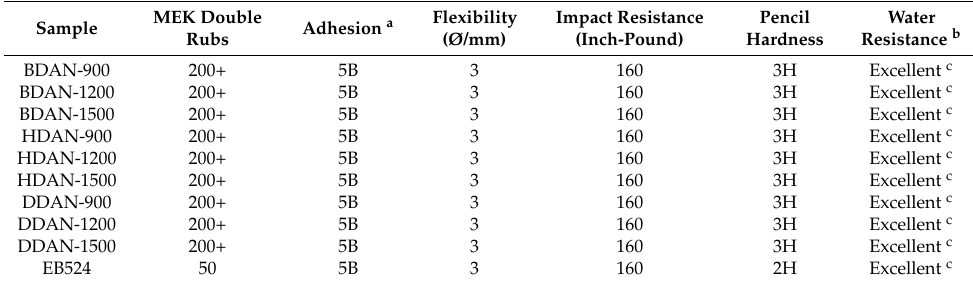
Table 7. Properties of oligolactide acrylate - based UV - curable ink films.